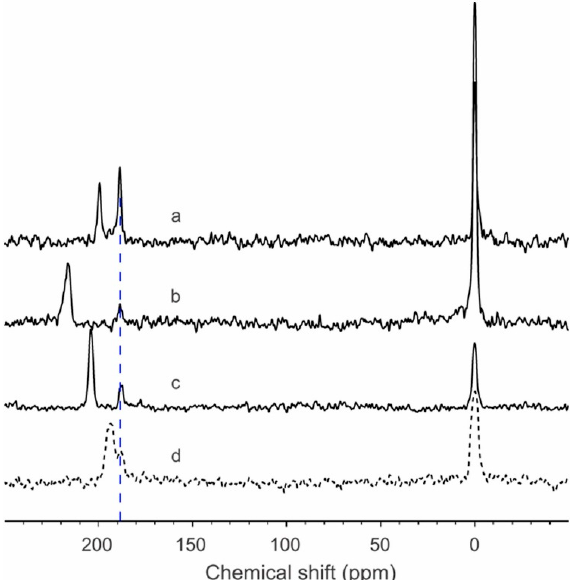
Figure 5. 129 Xe NMR spectra obtained at 30 °C of ionic liquid ‐ polyacrylate copolymer membranes: ( a ) poly[P 222 VB][BF 4 ]+acrylates, ( b ) poly[P 444 VB][BF 4 ]+acrylates, ( c ) poly[P 888 VB][BF 4 ]+acrylates, ( d ) poly[P 888 VB][Tf 2 N]+acrylates. The vertical dashed line marks the chemical shift of xenon in water. Reprinted with permission from reference [85]. Copyright 2021 Journal of Membrane Science .